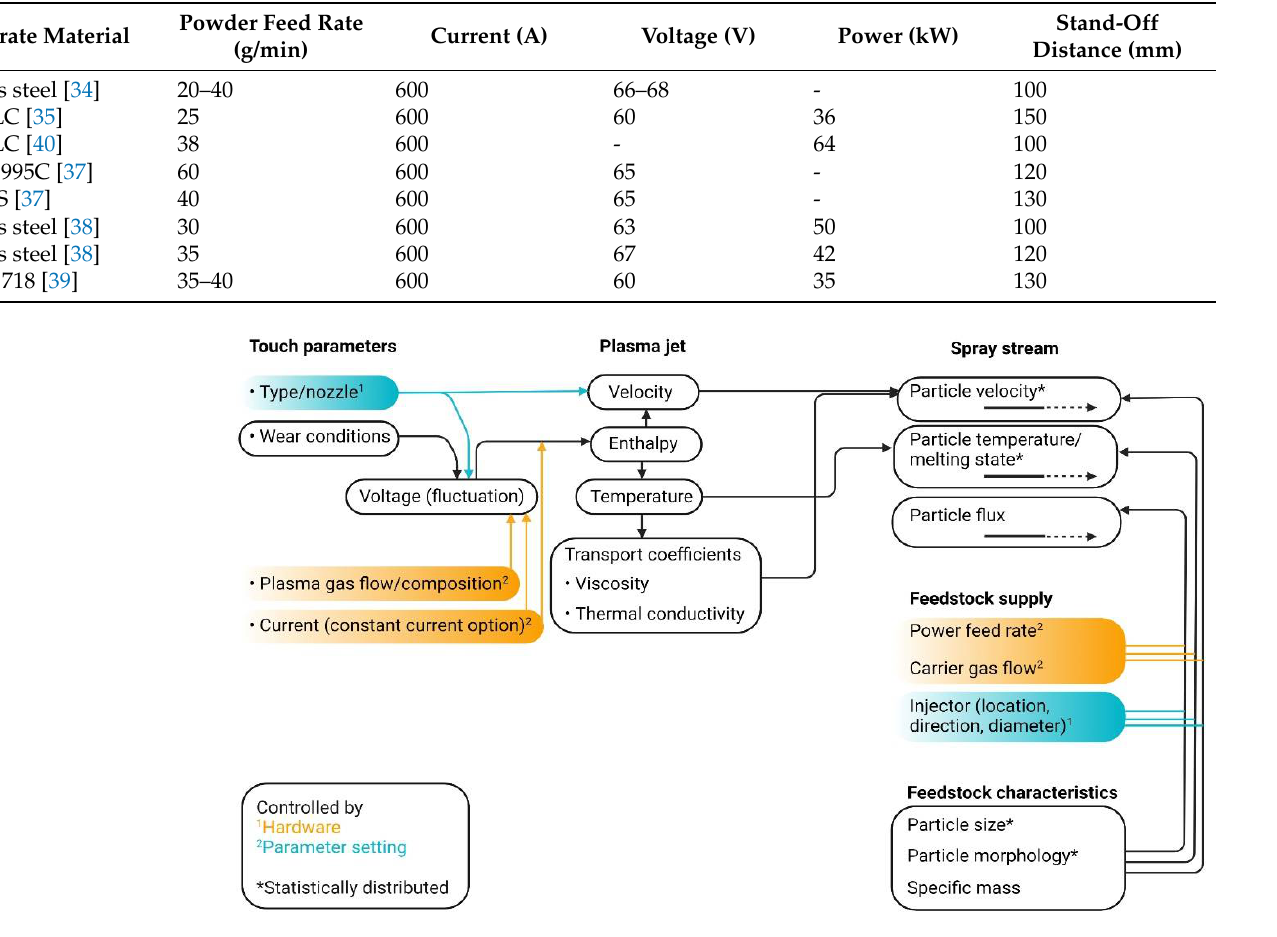
Figure 9. The plasma spraying parametersfor the top coat’s second stage.